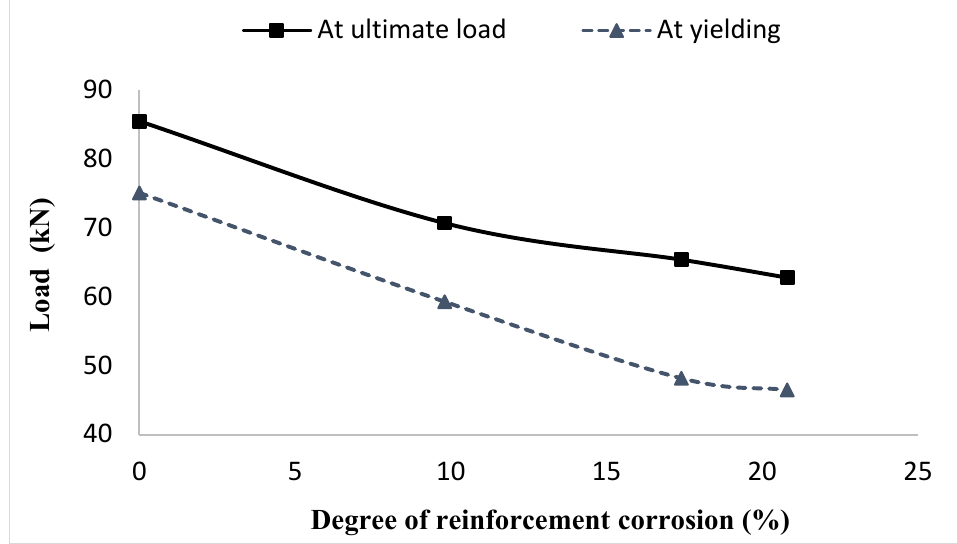
Figure 15. Reduction in load ‐ carrying capacity with degree of reinforcement corrosion.